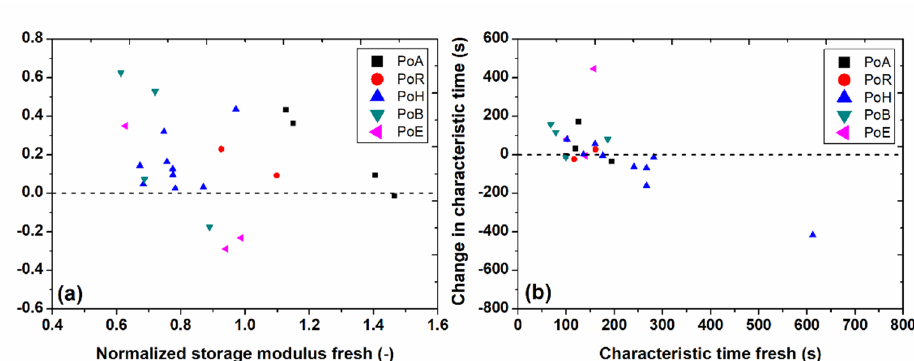
Figure 10. ( a ) Change in normalized equilibrium storage modulus, G (cid:48) ∞ / G (cid:48) (degraded–fresh) as a function of normalized equilibrium storage modulus, G (cid:48) ∞ / G (cid:48) of fresh mud samples from different ports, and ( b ) change in characteristic time, t r (degraded–fresh) as a function of characteristic time, t r of fresh mud samples from different ports. The dashed line represents the value where the degraded and fresh mud samples have same normalized equilibrium storage modulus or characteristic time.